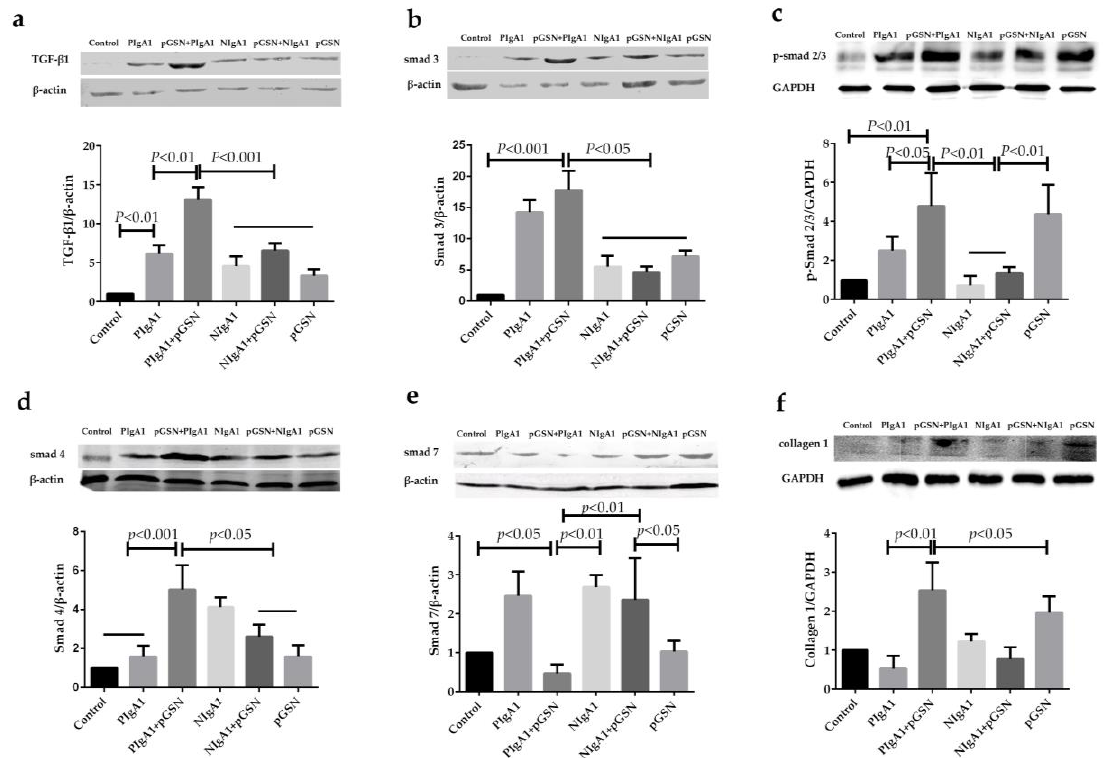
Figure 7. The comparison of TGF-β1, Smad3, p-Smad2/3, Smad4, Smad7, and collagen 1 expression in HMCs under different stimulation group. Comparison in six different HMCs stimulation group of ( a ) TGF-β1 expression; ( b ) Smad3 expression; ( c ) p-Smad2/3 expression; ( d ) Smad4 expression; ( e ) Smad7 expression; and ( f ) collagen 1 expression, which showed TGF-β1, Smad3, p-Smad2/3, Smad4, and collagen 1 expression have significance increased but Smad7 marked decreased in (pGSN + PIgA1) group. Each group have five test samples ( n = 5), the between-group differences were calculated with a one-way ANOVA and LSD test, the results were presented as means ± standard deviation (SD).